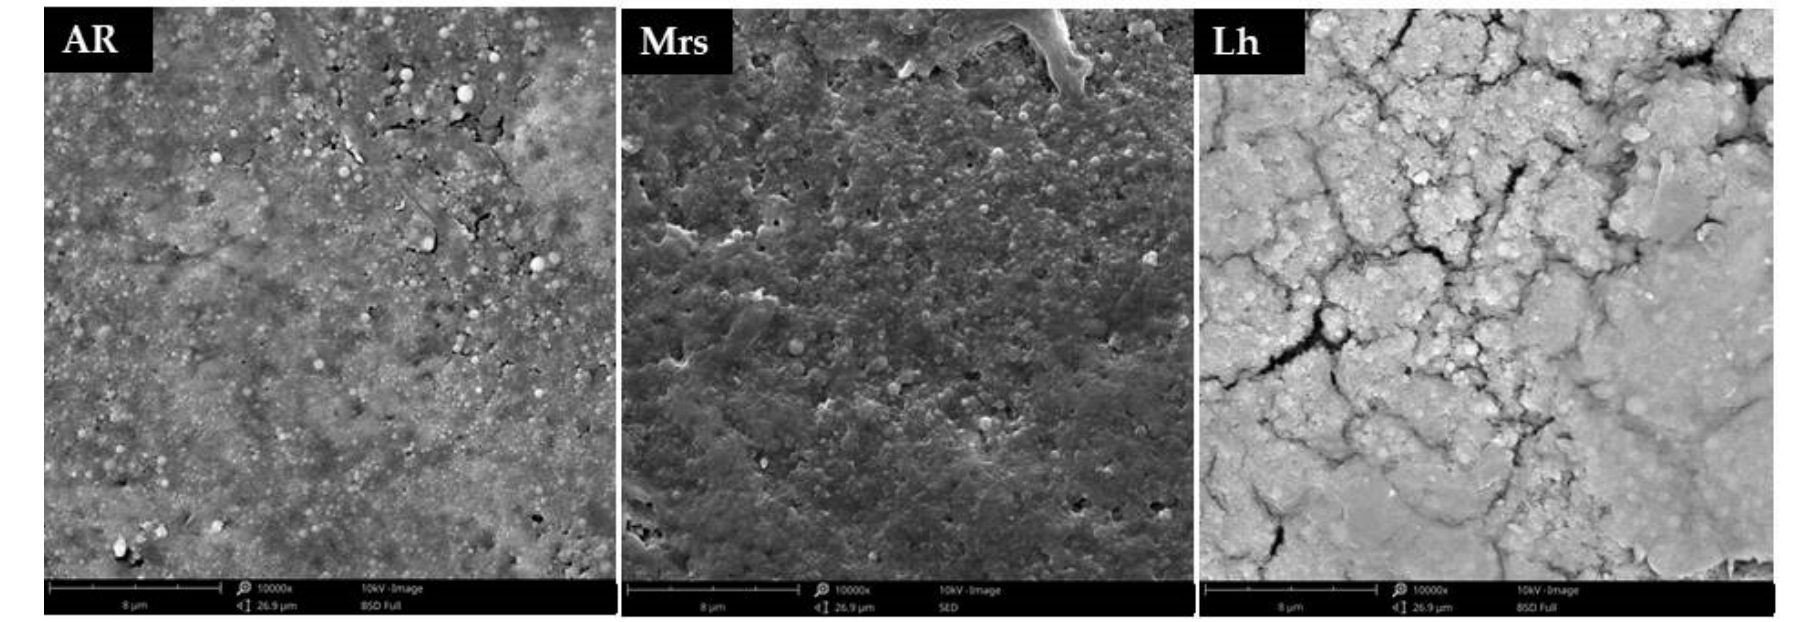
Figure 4. Effect of three breeds of hens differentiated by the eggshells color on on the shell microstructure, Ar—Araucana; Mrs—Marans; Lg—Leghorn.